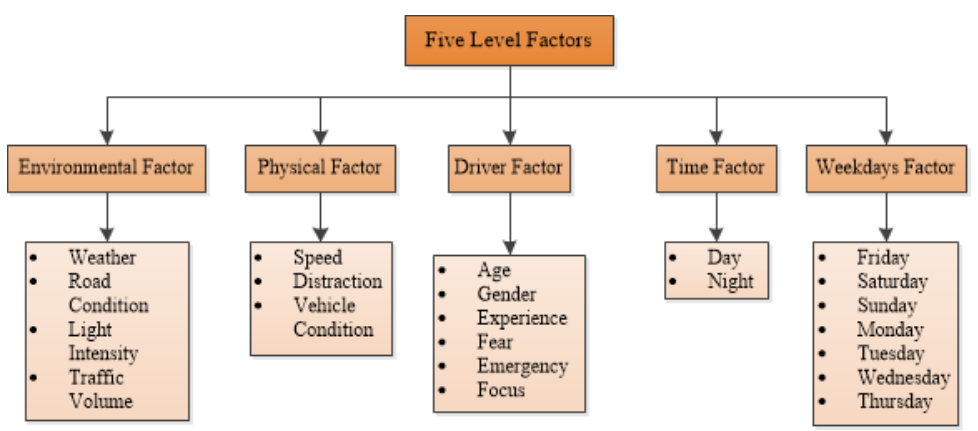
Figure 3. Five Level Factors of Collision in